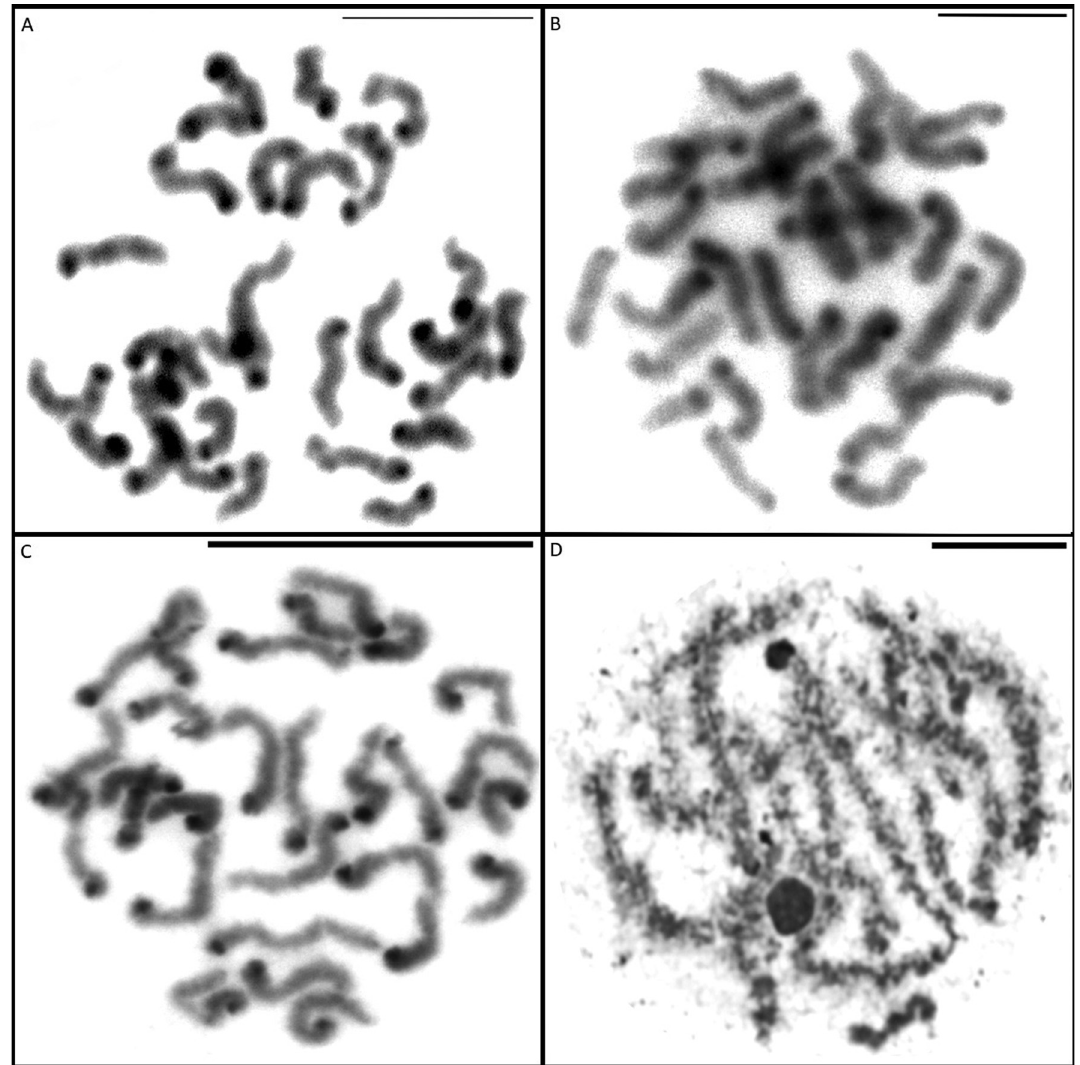
Figure 4 - Mitotic cells submitted to C-banding (A, B e C) and silver nitrate impregnation (D). (A) C. amphora , (B) C. crulsi and (C) C. villasboasi show- ing heterochromatin in the centromeric region of chromosomes. (D) C. villasboasi showing NORs in pachytene bivalent. Scale= 10 (cid:2)